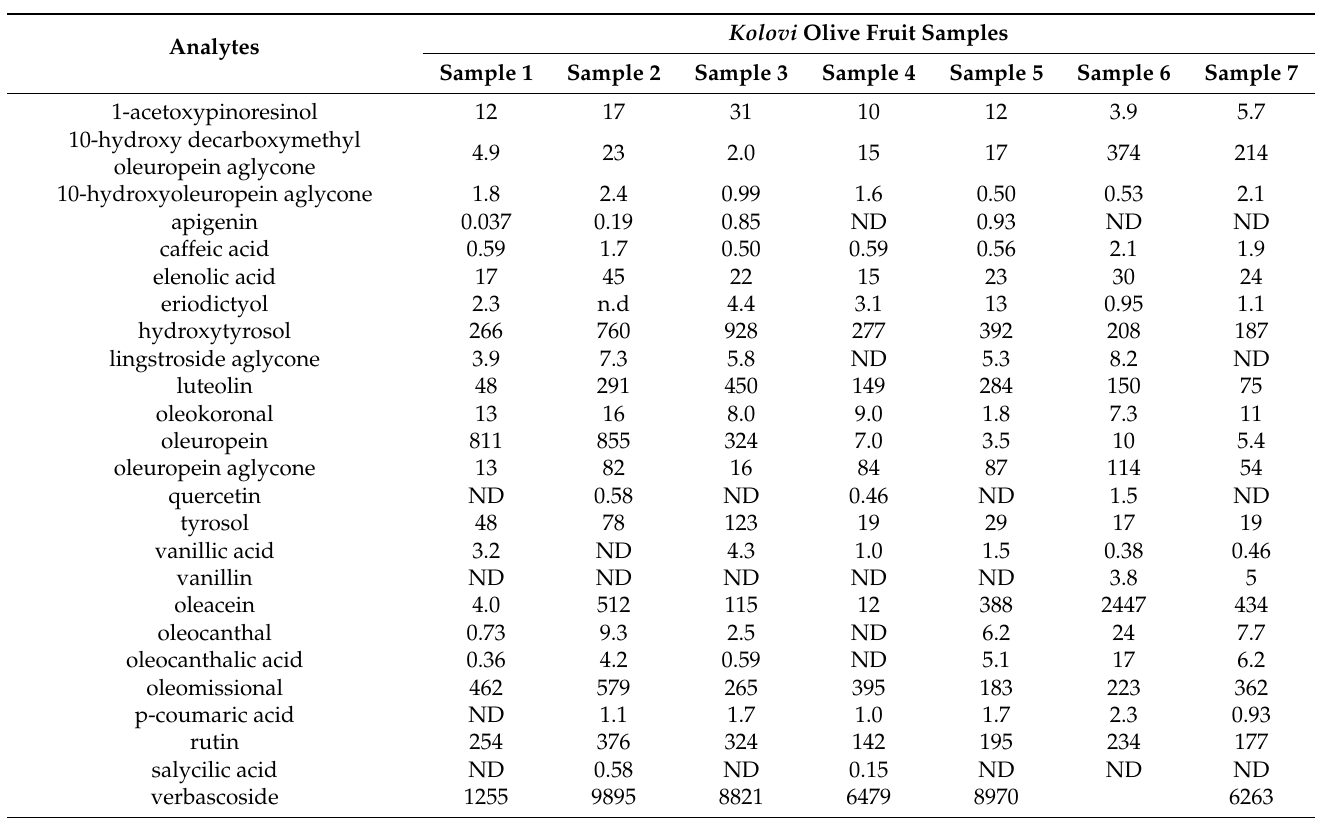
Table 1. Target screening results